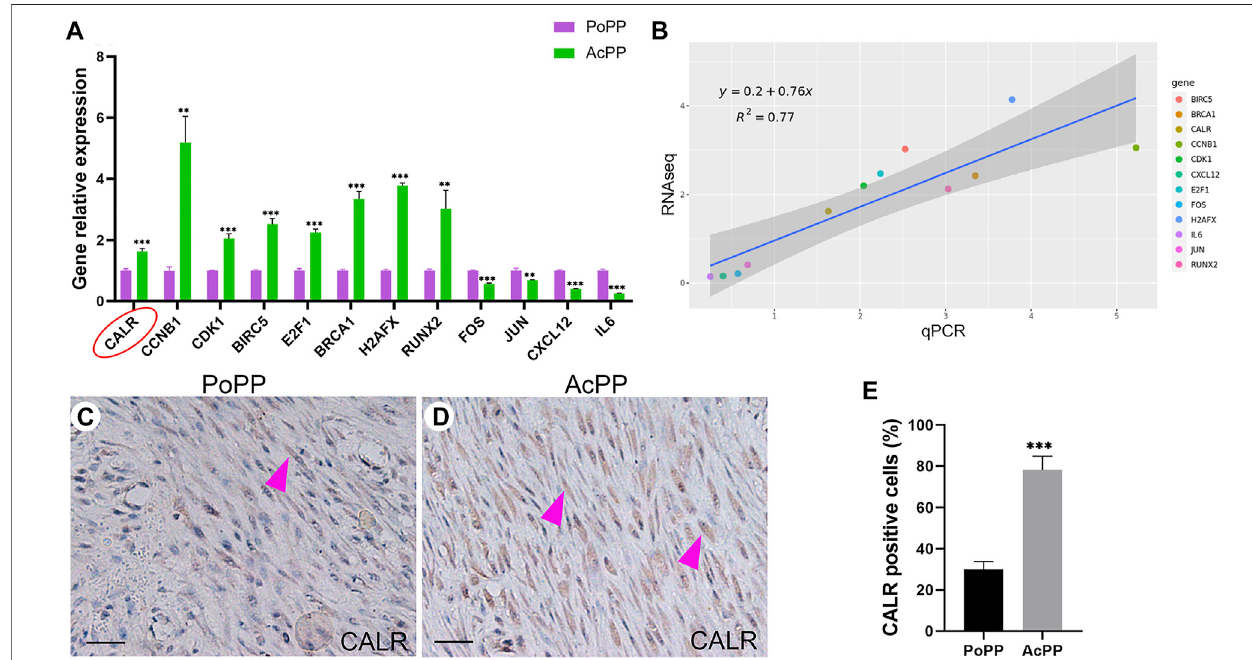
FIGURE 5 | RNA-seq results validated using qRT-PCR; CALR was highly signi fi cantly upregulated in the AcPP compared with the PoPP. (A) Histogram showing the mRNA expression levels of 12 DEGs (CCNB1, CDK1, E2F, RUNX2, BRCA1, H2AFX, CALR, FOS, JUN, BIRC5, IL6, and CXCL12, relative to that of GAPDH) in the AcPP (green) and the PoPP (pink) using qPCR. **: p < 0.01 and ***: p < 0.001. (B) Correlation analyses between the RNA-seq and qRT-PCR for the 12 DEGs, where a high correlation was detected ( R 2 = 0.77). (C,D) IHC of calreticulin (CALR); it is to be noted that weak positive staining was observed in cells that are sparsely populatedinthePoPPbut strong positivestainingincellsdensely populatedintheAcPP.Scale bar =50 µm. (E) PercentageofCALR positivecells; itistobenotedthat the percentage of CALR positive cells in the AcPP was signi fi cantly higher than that in the PoPP. *** p < 0.001.